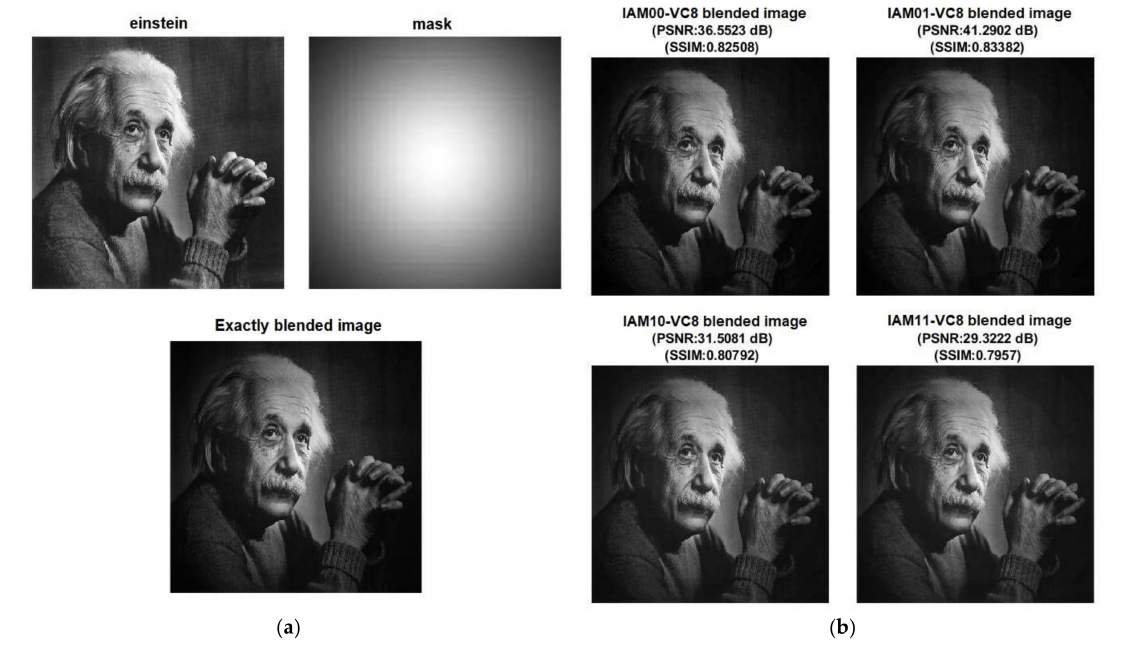
Figure 6. ( a ) Einstein and mask images, and the exactly blended image; ( b ) Blended images obtained using various inexact array multipliers (IAM00-VC8, IAM01-VC8, IAM10-VC8, and IAM11-VC8) based on vertical cut VC8 made on the exact array